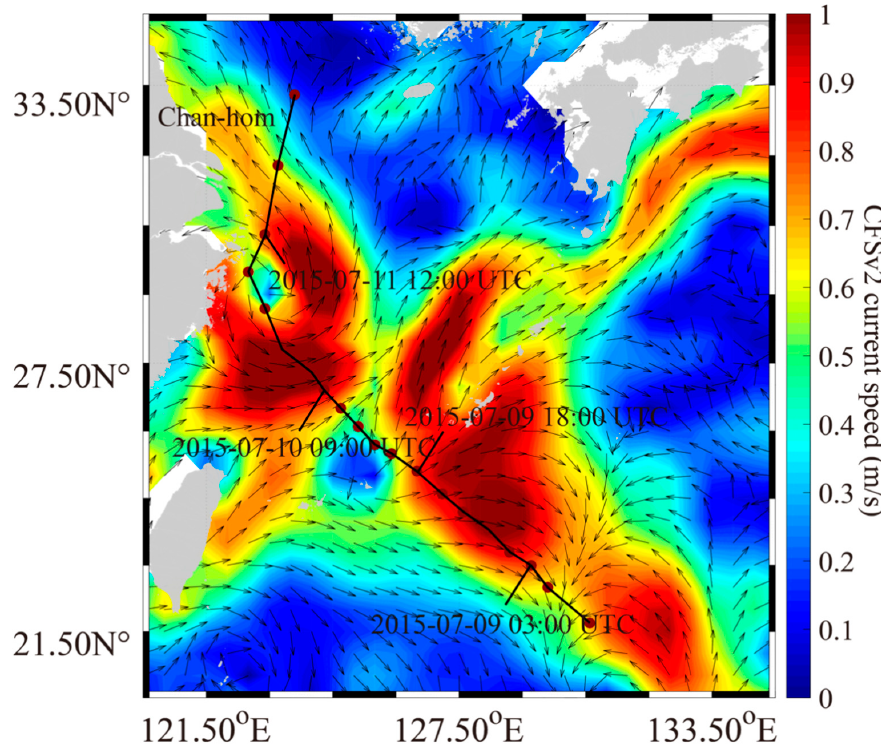
Figure 3. Sea-surface-current vector map from the Climate Forecast System Version 2 (CFSv2) model at 06:00 UTC on 11 July 2015, in which the black line is the track of Typhoon Chan-hom.